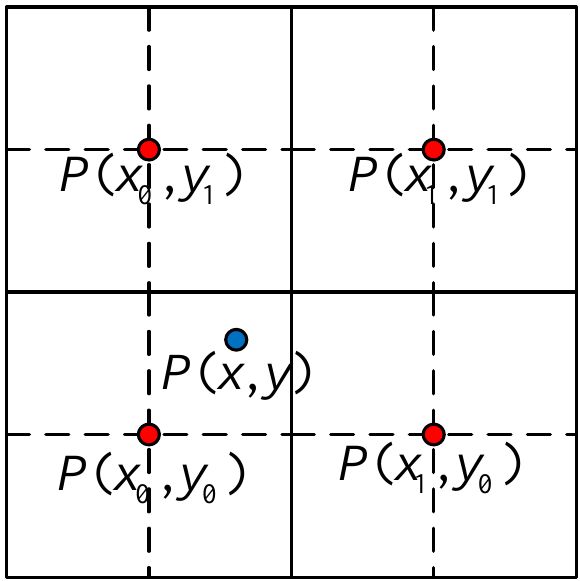
Figure 5. Bilinear interpolation.